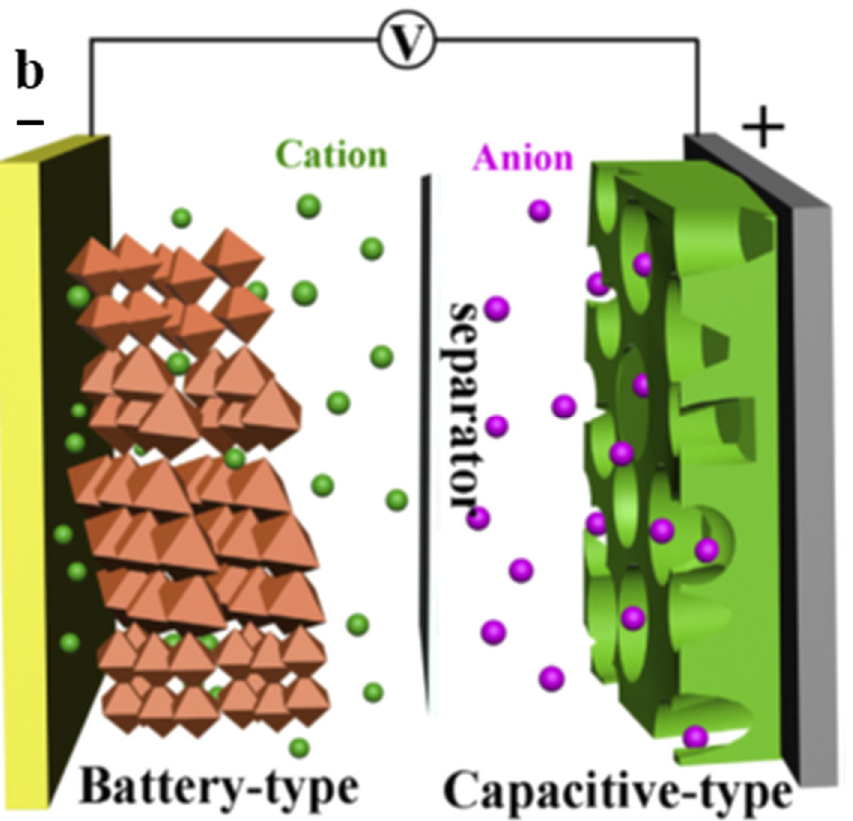
Figure 8. Scheme of the metal ion supercapacitor, “Reproduced with permission from [54], Elsevier, 2021”.